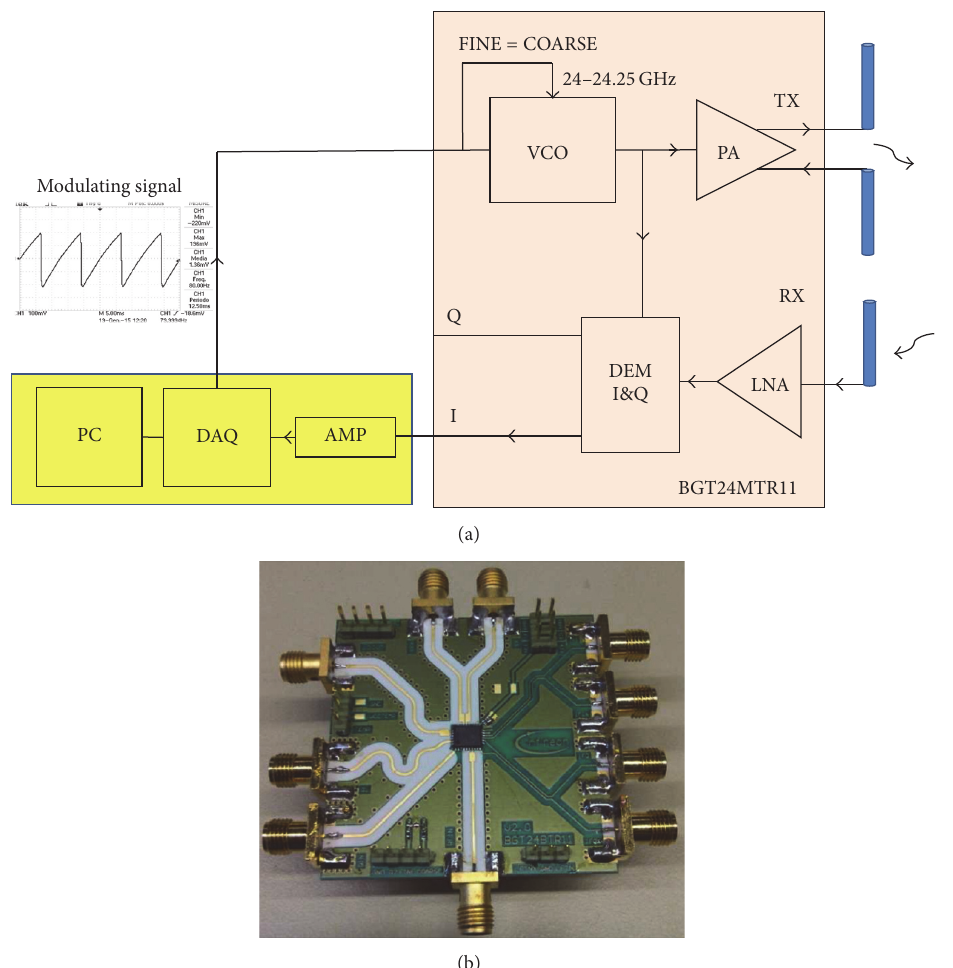
Figure 1: Schematic of the considered FMCW radar system (a) and photo of the BGT24MTR11 integrated circuit by Infineon (b).